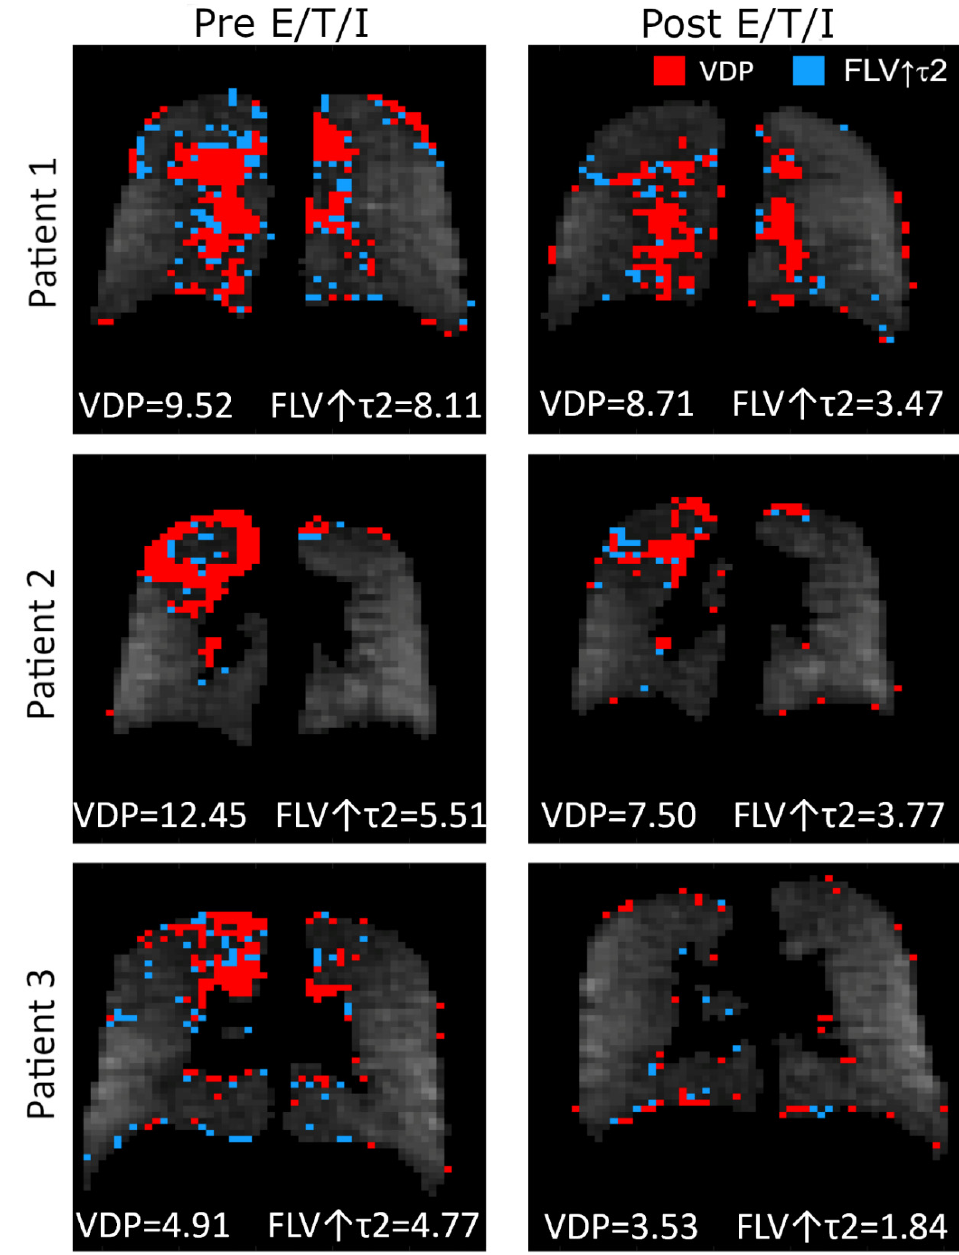
Figure 4. Effect of elexacaftor/tezacaftor/ivacaftor on the distribution of non-ventilating lung units. E/T/I: elexacaftor/tezacaftor/ivacaftor. VDP: Ventilation defect percentage. FLV ↑ τ 2: fractional lung volume with prolonged gas washout